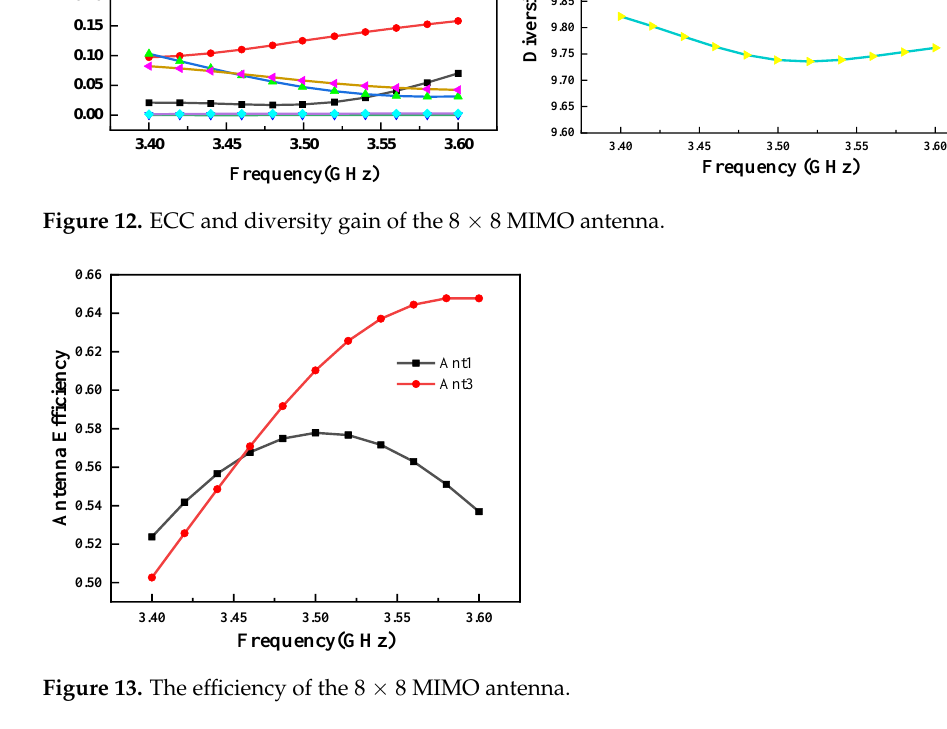
Figure 14. Measured radiation patterns of the proposed antenna at 3.5 GHz in ( a ) XOY plane and ( b ) XOZ plane.